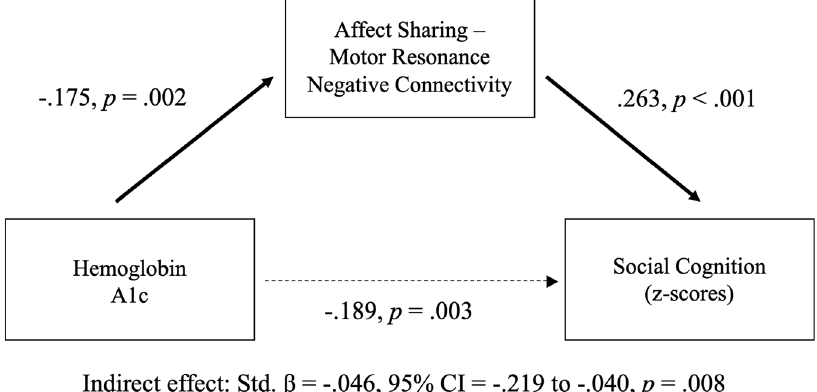
Fig. 4 Functional Connectivity Mediation of Hemoglobin A1c and Social Cognition Across SSD and HC Groups. The association between hemoglobin A1c and overall social cognition was partially mediated by negative connectivity between the affect sharing and motor resonance networks ( n = 253).